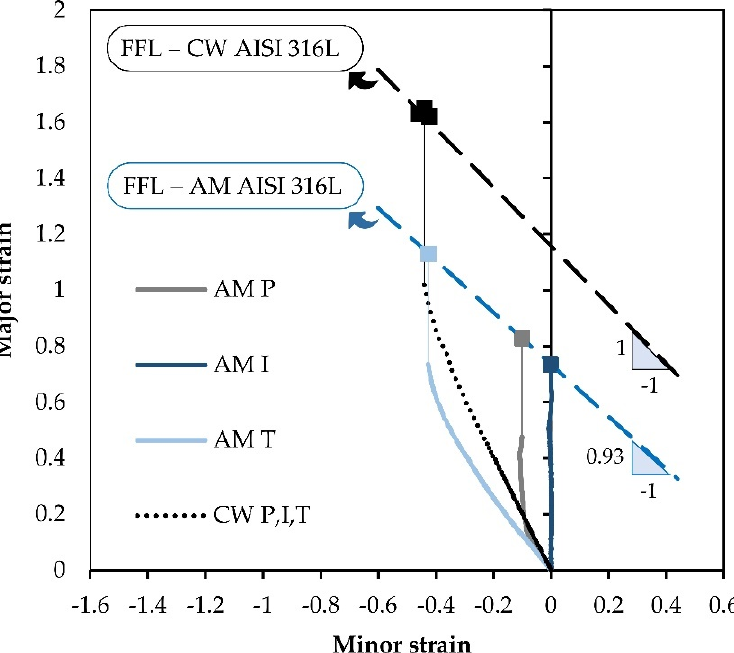
Figure 4. Fracture forming limits of the additively deposited and wrought commercial AISI 316L stainless-steel sheets in principal strain space (data obtained from [14]).